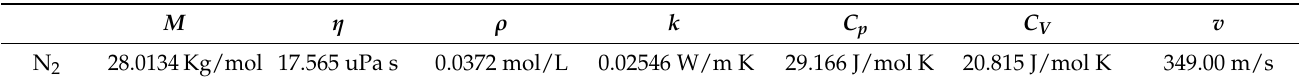
Table 1. Molar mass M and thermophysical properties, i.e., viscosity coefficient η , density ρ , thermal conductivity k , specific heats at constant pressure C p and constant volume C V , speed of sound v , of pure nitrogen at atmospheric pressure and room temperature as reported on NIST database [28].